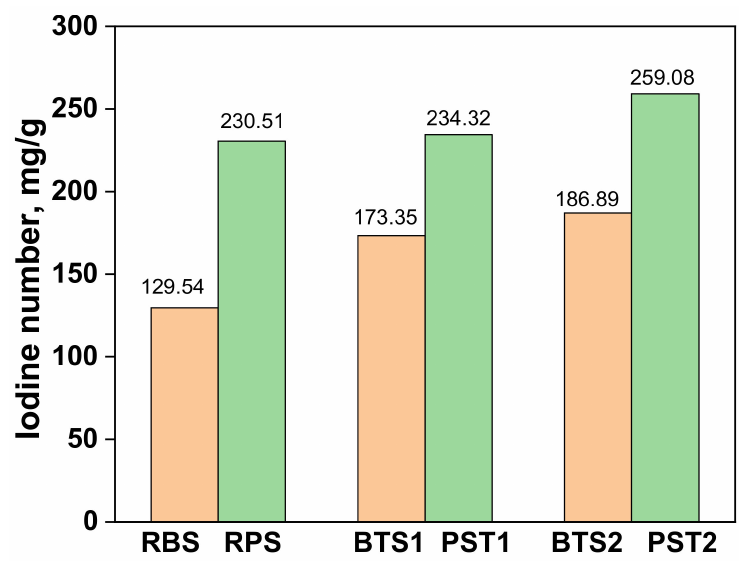
Figure 1. Iodine numbers recorded for raw and treated